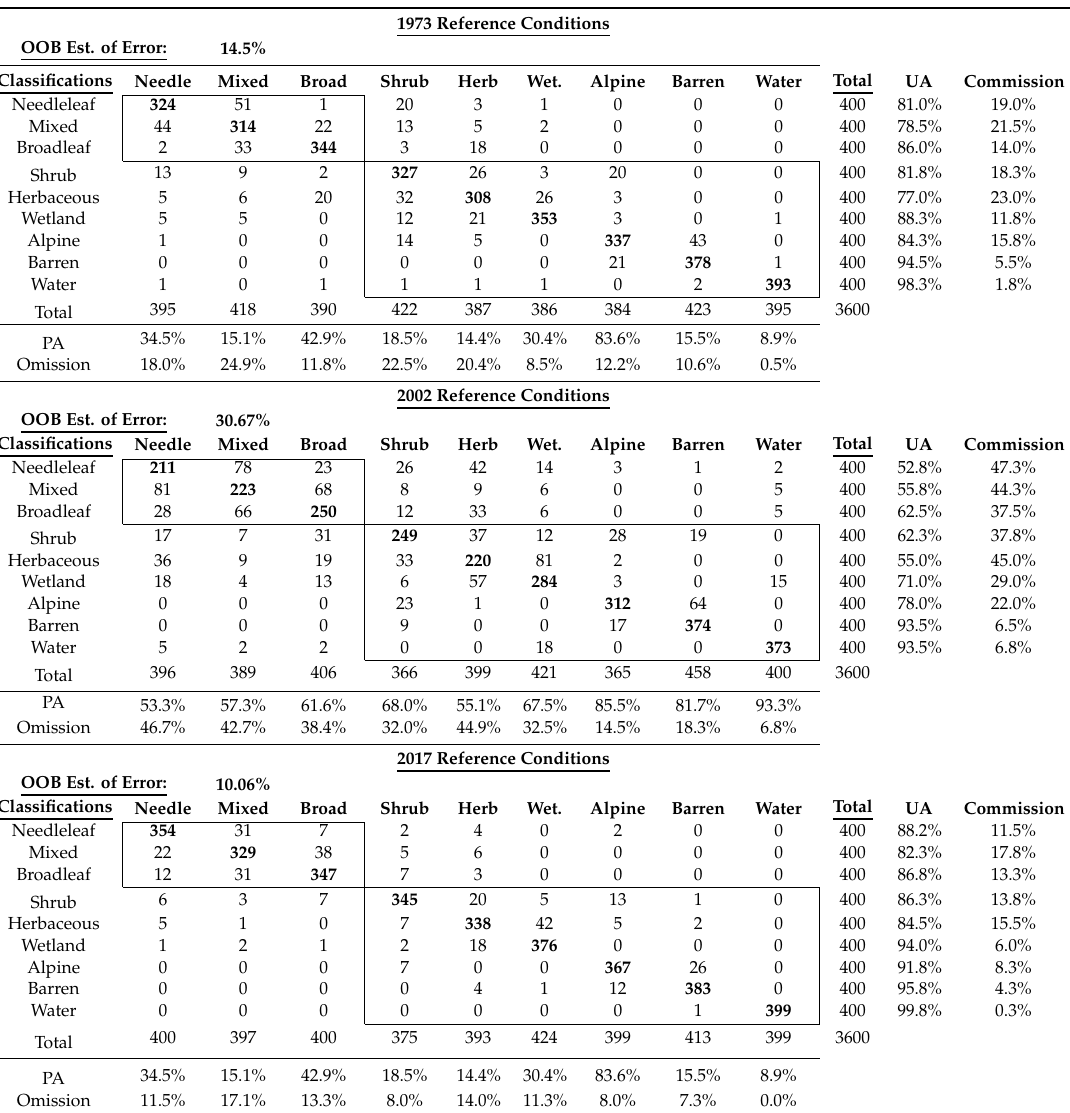
Table 4. Confusion matrices summarizing out of bag error estimation rates for each land-cover type. Bold lines denote forest and non-forest land-cover